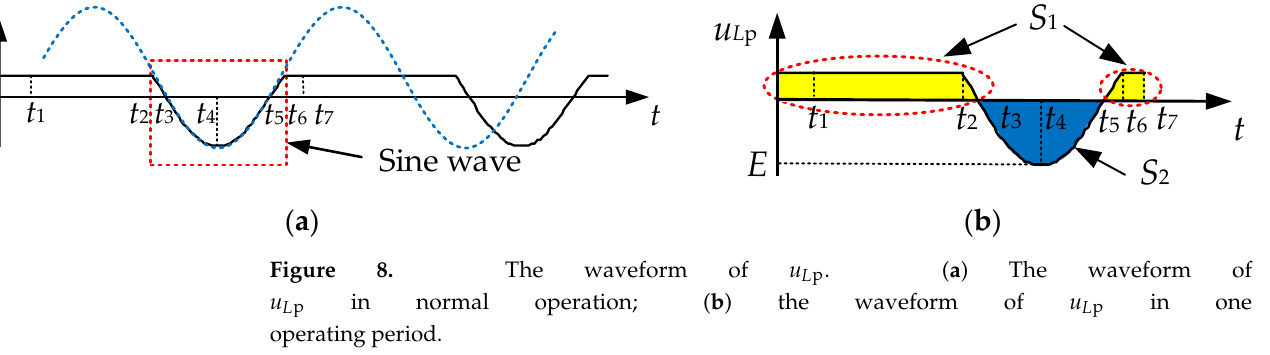
Figure 8. The waveform of u L p . ( a ) The waveform of u L p in normal operation; ( b ) the waveform of u L p in one operating period.